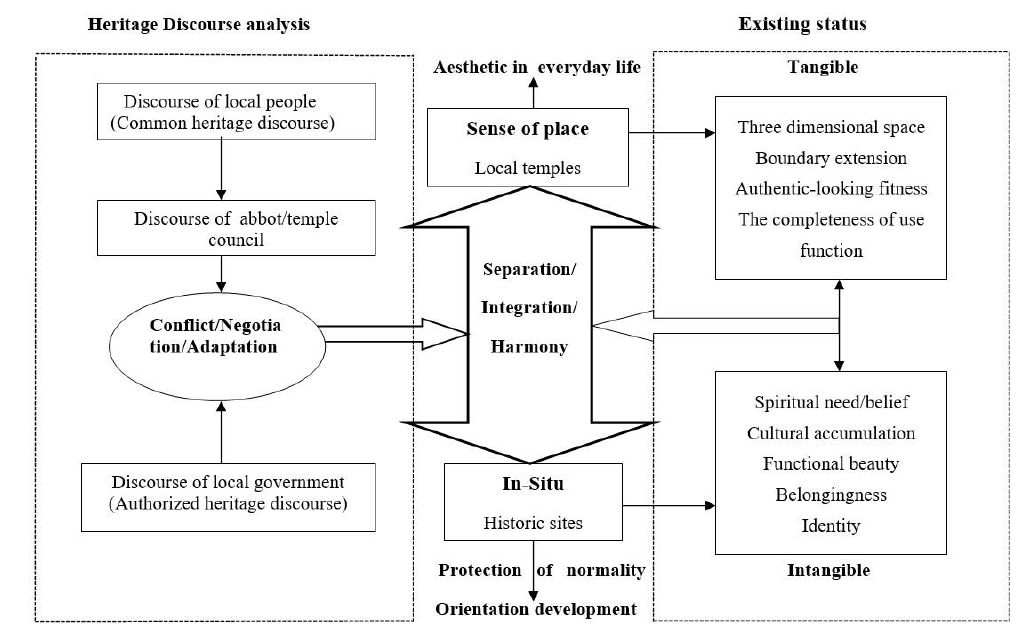
Figure 1. Conceptual framework of the sense of place and in-situ in the local temple with the historic